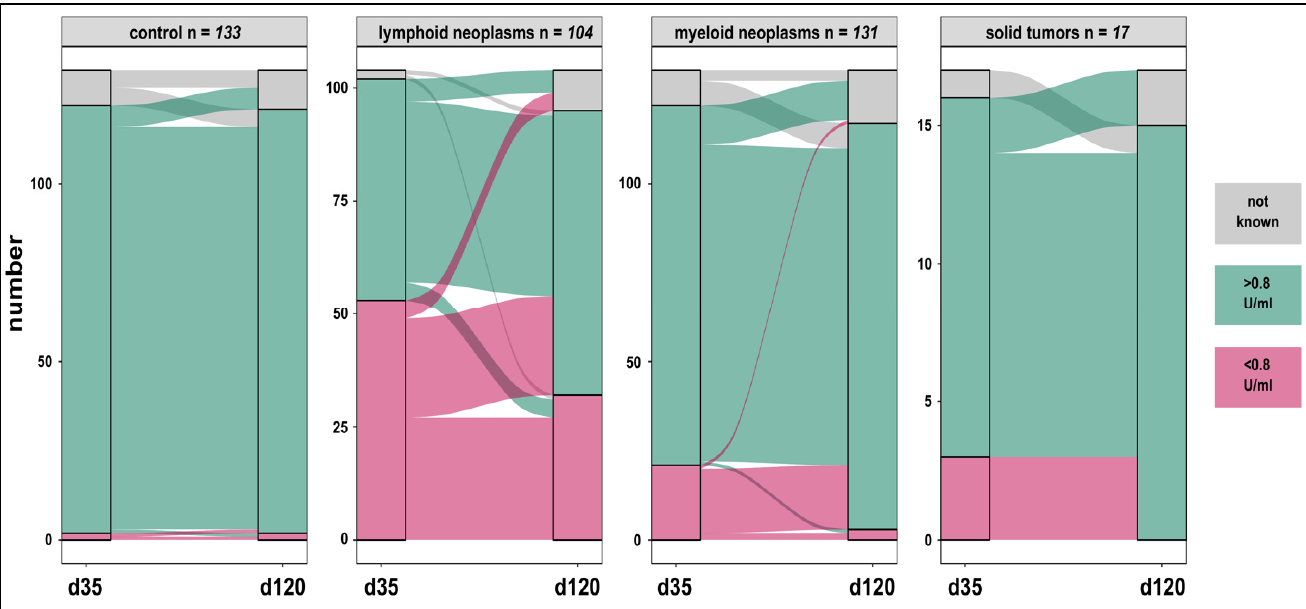
Figure 2. Humoral anti-spike-specific responses in patients and controls on day 35 and day 120 after vaccination. Specific IgG responses were maintained at high rates in controls (98%) and increased in patients with oncologic malignancies on checkpoint inhibitors (81% to 100%), lymphoid (48% to 66%), and myeloid neoplasms (82% to 97%). A complete loss of the anti-spike IgG was rarely seen.